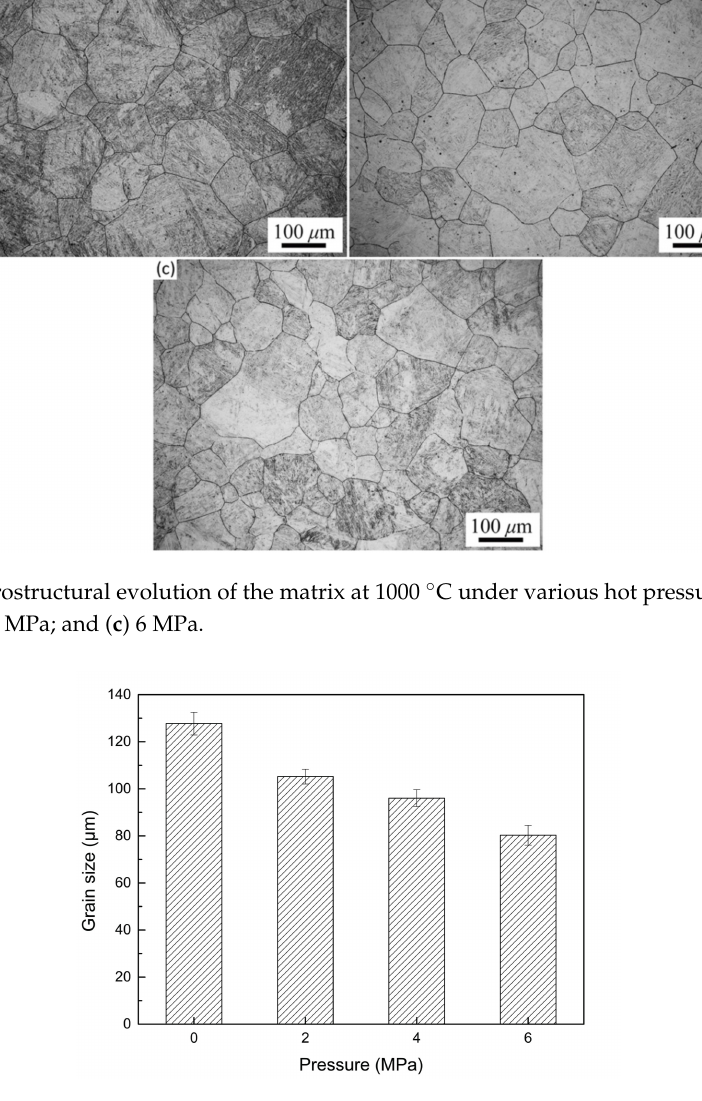
Figure 14. Grain sizes of the matrix at 1000 ◦ C under various hot pressures for 30